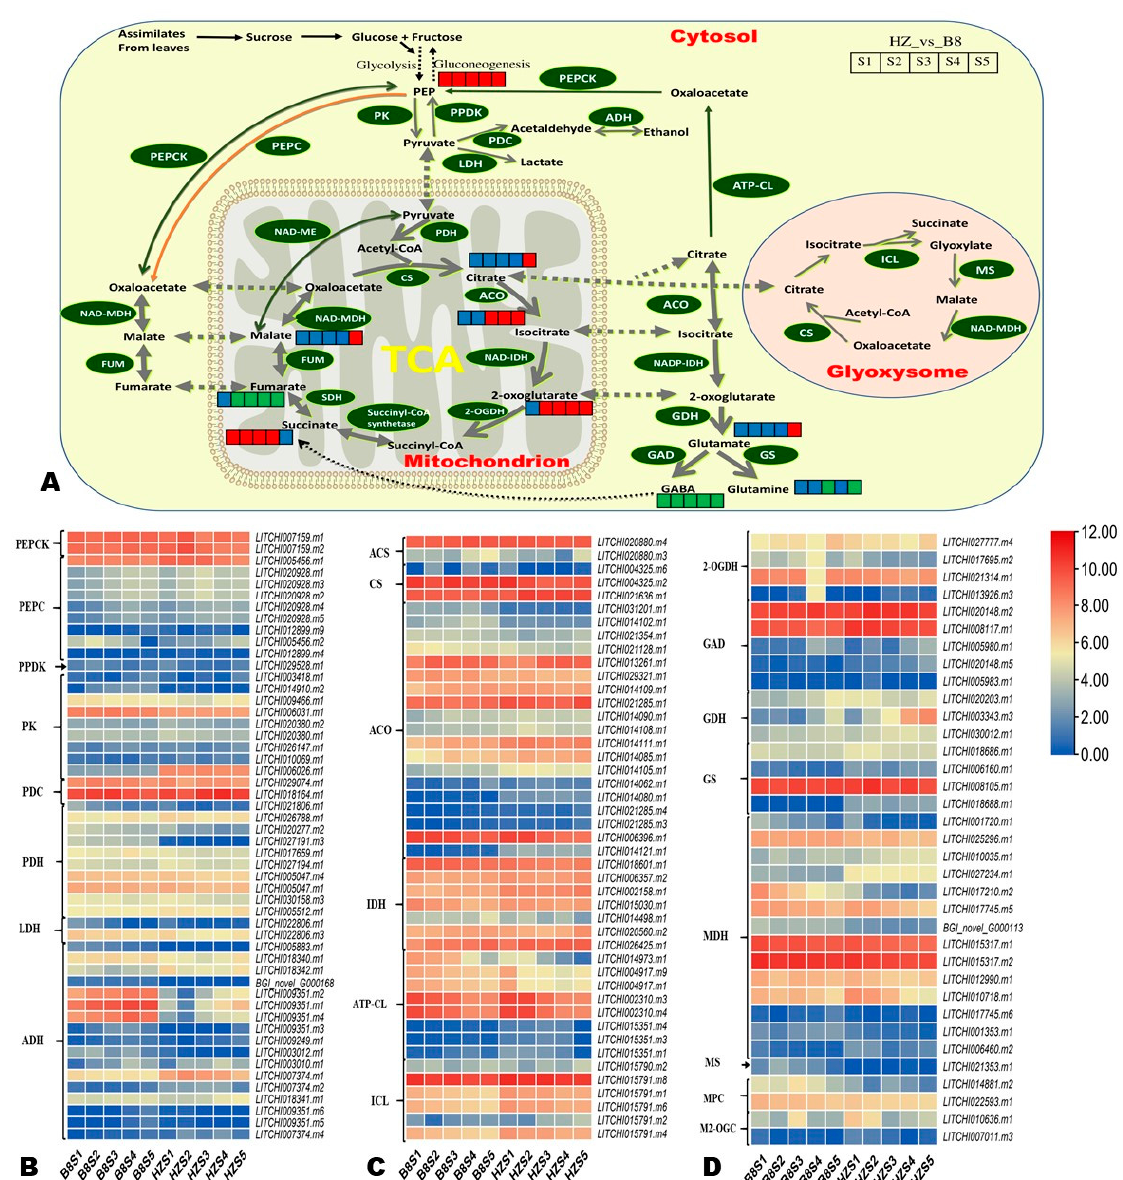
Figure 7. ( A ) Overview of the probable regulation of some key organic acids mapped to metabolic pathways in pairwise comparisons between HZ and B8 during fruit development. The red color small rectangle indicates that the metabolite content is significantly upregulated; the small green rectangle indicates that the metabolite content is significantly downregulated; the small blue rectangle indicates no significant difference in that metabolite’s content. ( B – D ) Heatmap of log2FC values of the expression of key differentially expressed organic acid metabolism genes in HZ and B8 during fruit development. PEP, phosphoenolpyruvate; PEPC, PEP carboxylase; PEPCK, PEP carboxykinase; PPDK, pyruvate orthophosphate dikinase; PK, pyruvate kinase; PDC, pyruvate decarboxylase; PDH, pyruvate dehydrogenase; LDH, lactate dehydrogenase; ADH, alcohol dehydrogenase, ACA, acetyl-CoA synthase; CS, citrate synthase; ACO, aconitase, IDH, isocitrate dehydrogenase; ATP-CL, ATP-dependent citrate lyase; ICL, isocitrate lyase; 2-OGDH, 2-oxoglutarate dehydrogenase; GAD, glutamate decarboxylase; GDH, glutarate dehydrogenase; GS, glutamine synthetase; MDH, malate dehydrogenase; MS, malic synthase; MPC, mitochondrial pyruvate carrier 2; M2-OGC, mitochondrial oxoglutarate